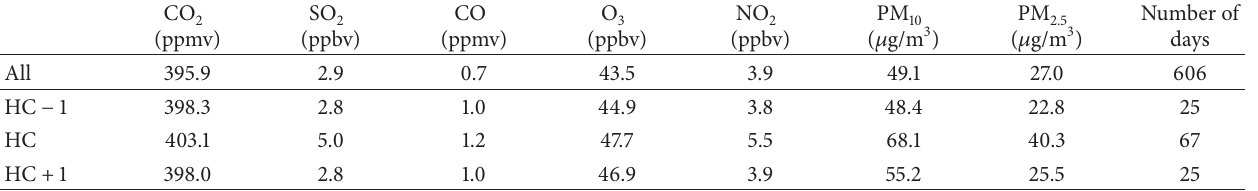
and air pollutants on HC, HC − 1, and HC + 1 case and their 2